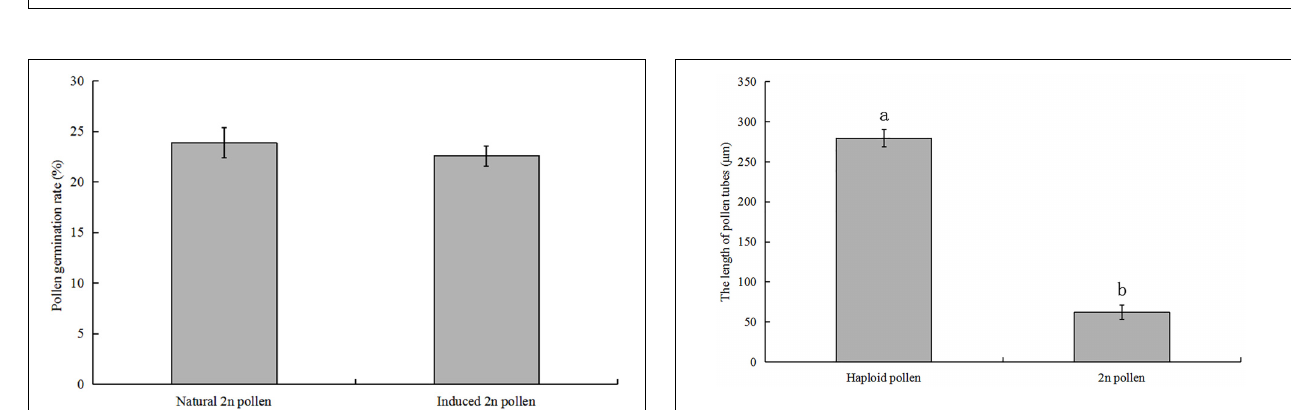
second division restitution (SDR) (Ramanna and Jacobsen, 2003), and indeterminate meiotic restitution (IMR) (Lim et al., 2001). Pairing and separation of the homologous chromosomes